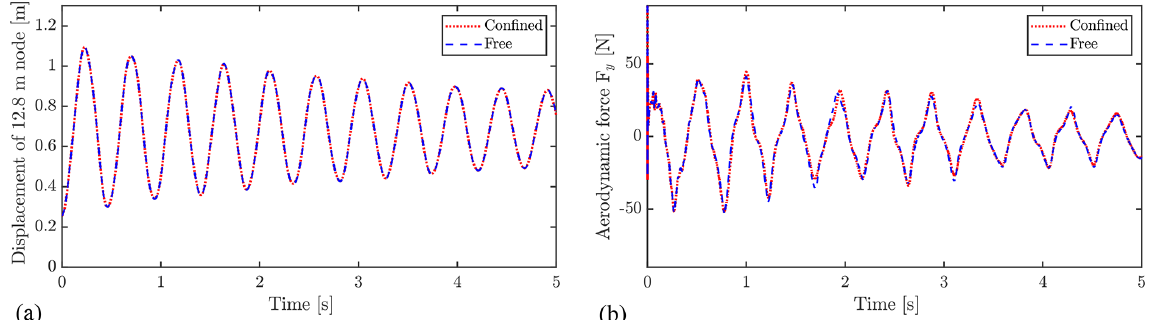
Figure 14. Confinement effect on displacement (a) and aerodynamic forcing (b) on the node at 12.8m.